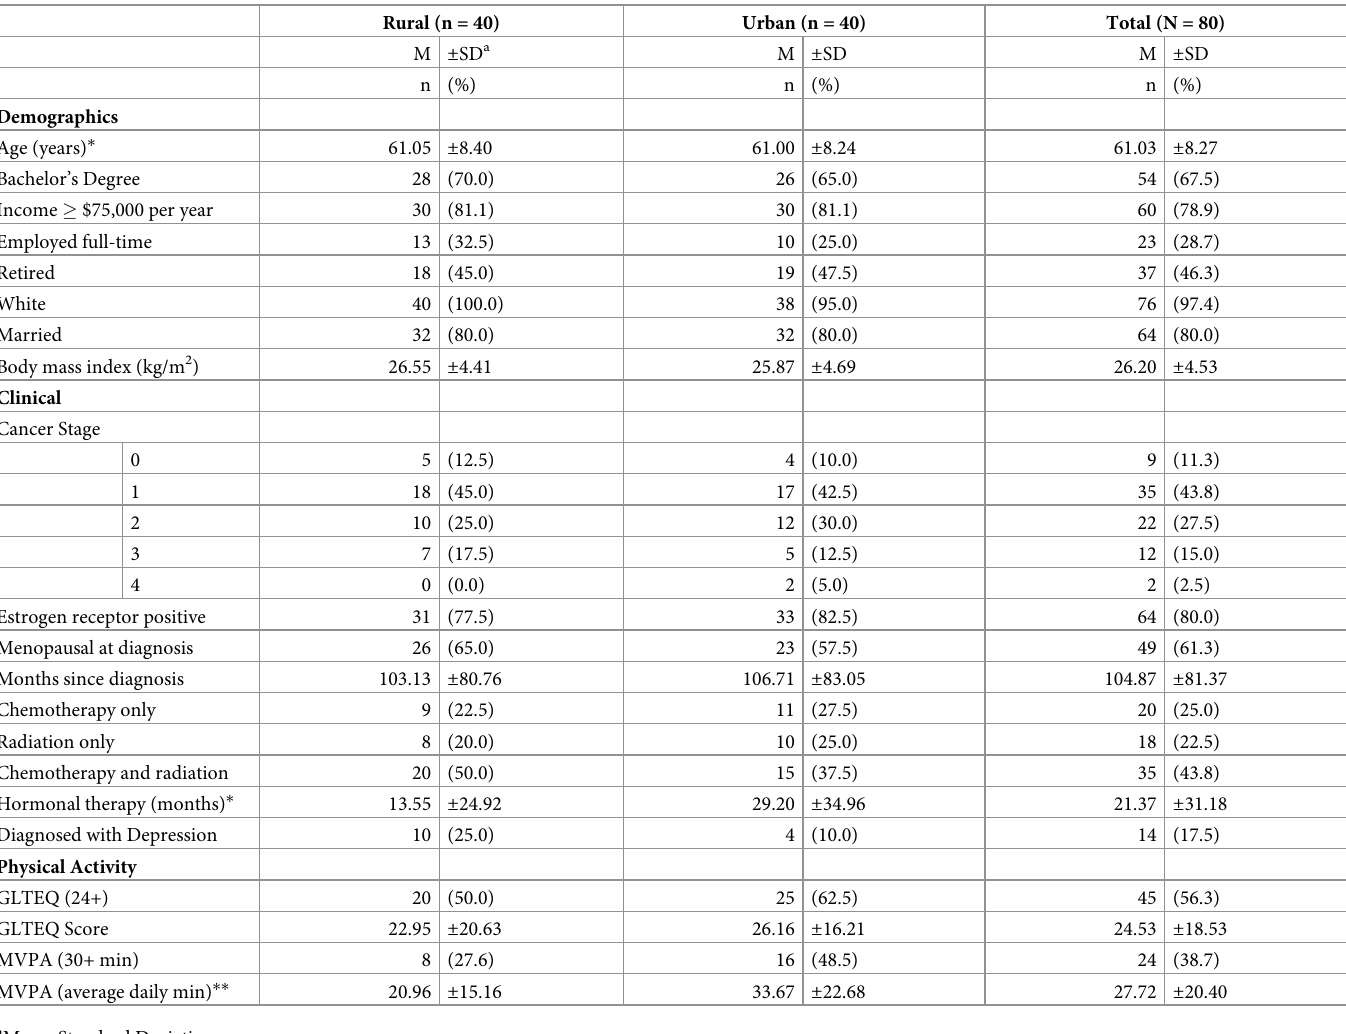
Table 1. Participant